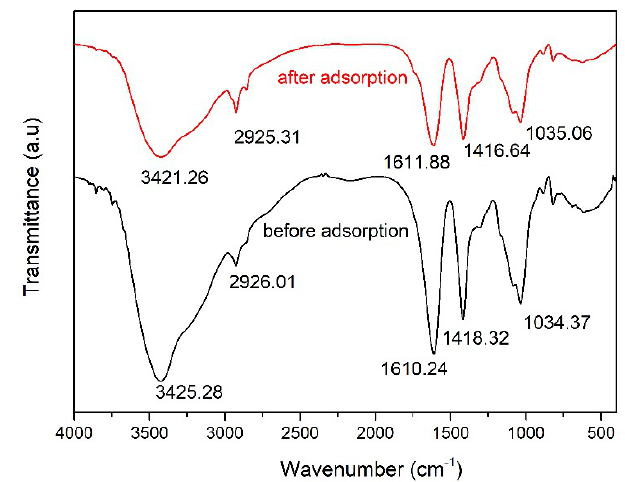
Figure 7. FTIR images of CA beads before and after the adsorption.